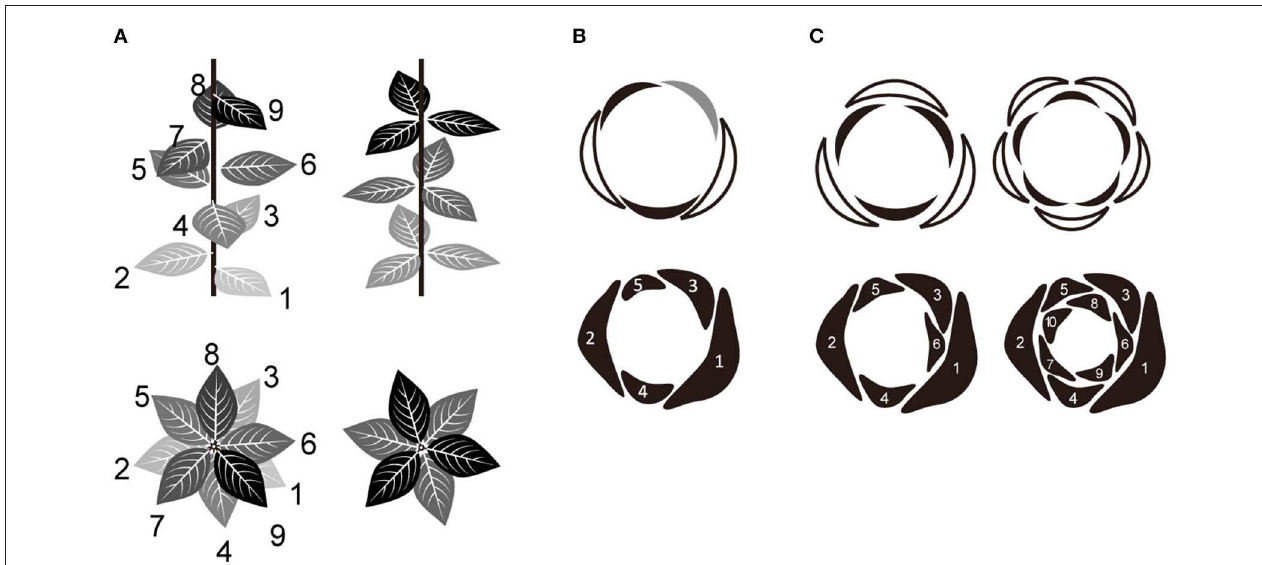
FIGURE 1 | Relationship between spiral and whorl phyllotaxis. (A) Two major categories of phyllotaxis; spiral (left) and whorled (right). (B) Quincuncial aestivation of five tepals derived from the Fibonacci spiral (with a divergence angle of 137 ◦ ). The arrangement of each organ in relation to neighboring ones was identified (top) as either external (white), internal (black), or alternating (gray). (C) Trimerous and pentamerous double-whorls (top) derived from the Fibonacci spiral (bottom). In some species, primordia initiate individually in a spiral order and then develop into whorled arrangements during floral development via a post-meristematic interaction between them. The numbers in (A–C) indicate the initiation order of each